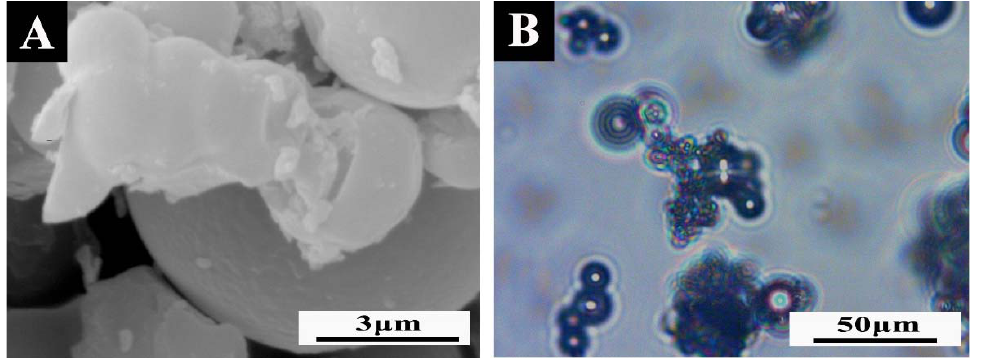
Figure 7. ( A ) SEM and ( B ) OM of damaged microcapsules.